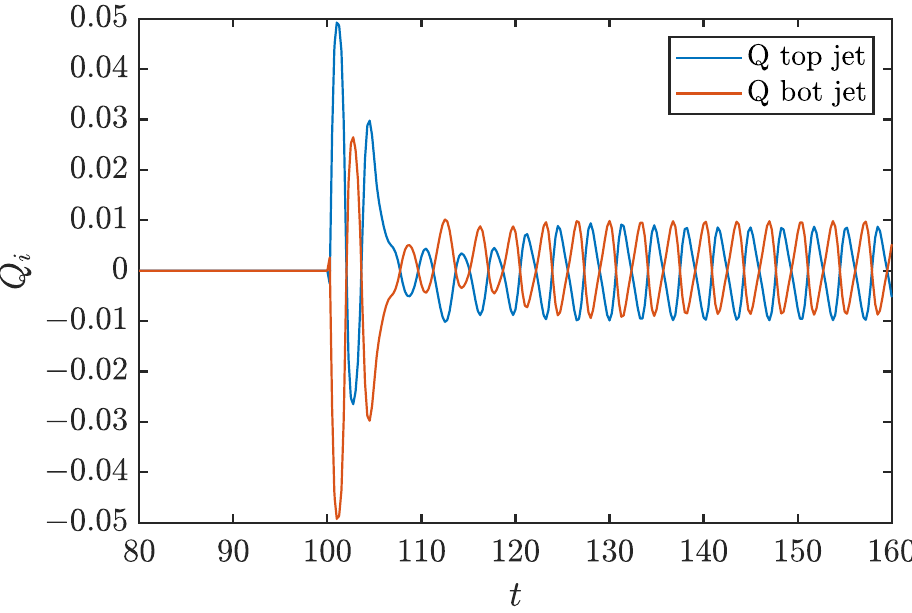
Figure 9. Flow rate through each jet as a function of time after applying the DRL